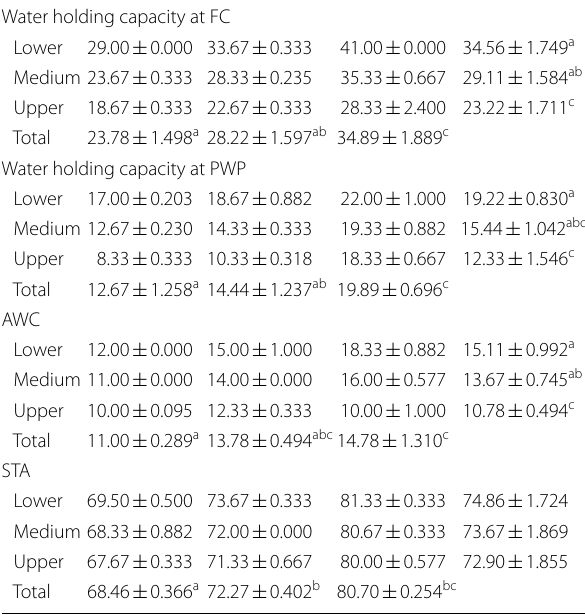
Table 4 Interaction effects of landscape positions